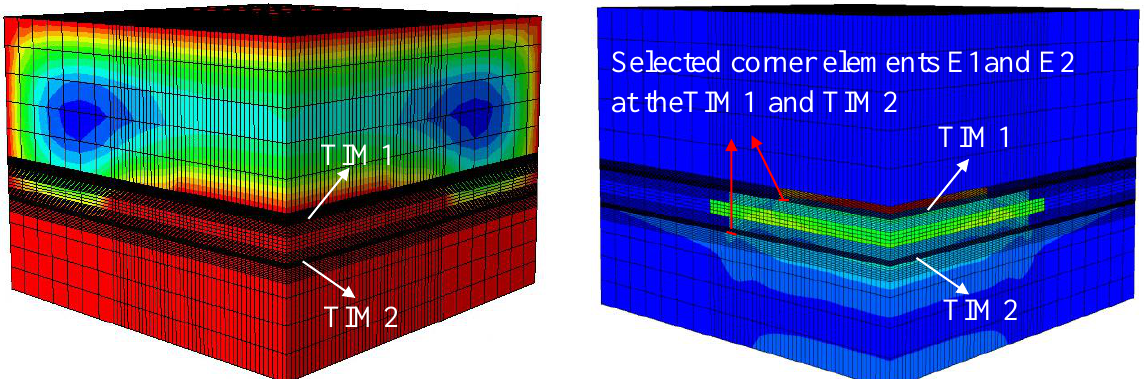
Figure 6: Stress distribution of 1/4 SiC-IGBT power module.